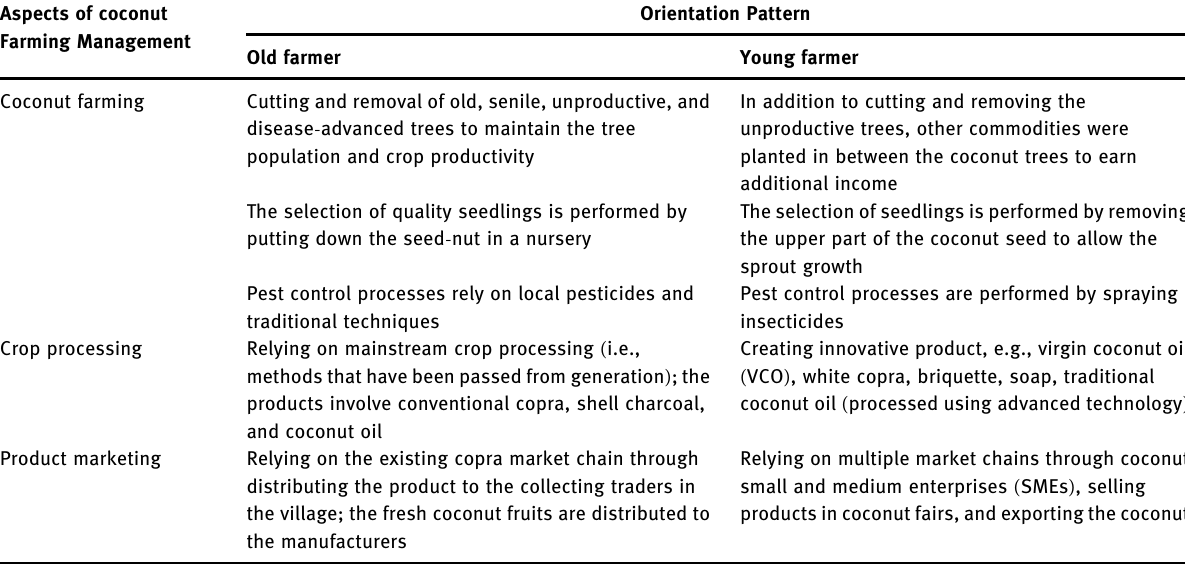
Table 1: Characteristics of orientation of old farmers and young farmers in coconut agribusiness Aspects of coconut Farming